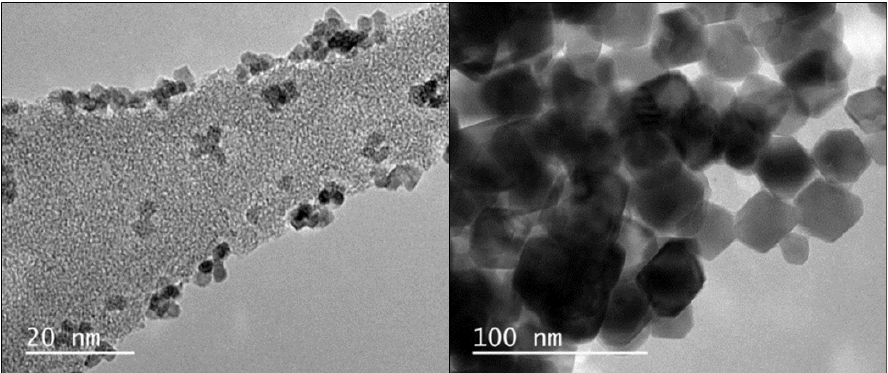
Figure 7. Transmitted-electron microscopy. (TEM) of CeO 2 nanoparticles deposited on the TEM grid, with diameters in the range of 4 ± 1 nm ( left ) and 40 ± 10 nm ( right